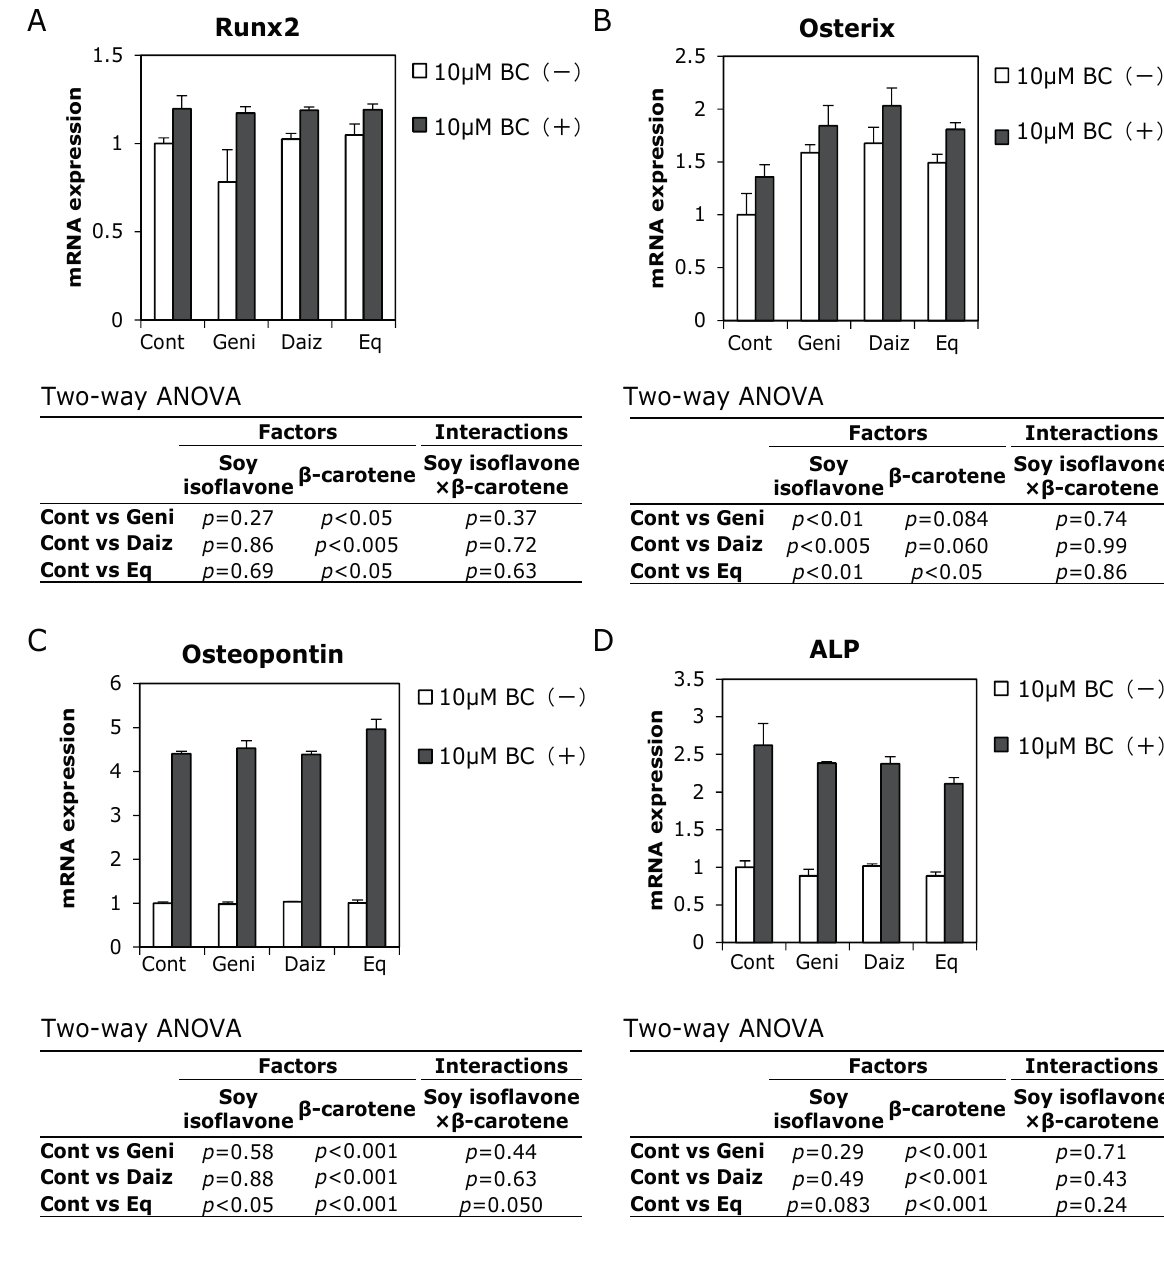
Figure 4. Combined effect of soy isoflavones with β -carotene on osteoblastogenic-related mRNA expression. MC3T3-E1 cells were precultured in α -MEM/10% FBS for 24 h and subsequently cultured in medium with 10% charcoal-treated FBS containing 10 μ M soy isoflavones with (black bars) or without (open bars) 10 μ M β -carotene (BC) for one day. Figures show the ratio of Runx2 ( A ), osterix ( B ), osteopontin ( C ), and ALP ( D ). mRNA levels are relative to control without β -carotene. Data are expressed as means ± SEM ( n = 3). Statistical analysis was performed using two-way ANOVA with the two factors being soy isoflavones (control: Cont., daidzein: Daiz., genistein: Geni., and equol: Eq.) and β -carotene. Significance was determined at p < 0.05. Data are from representative